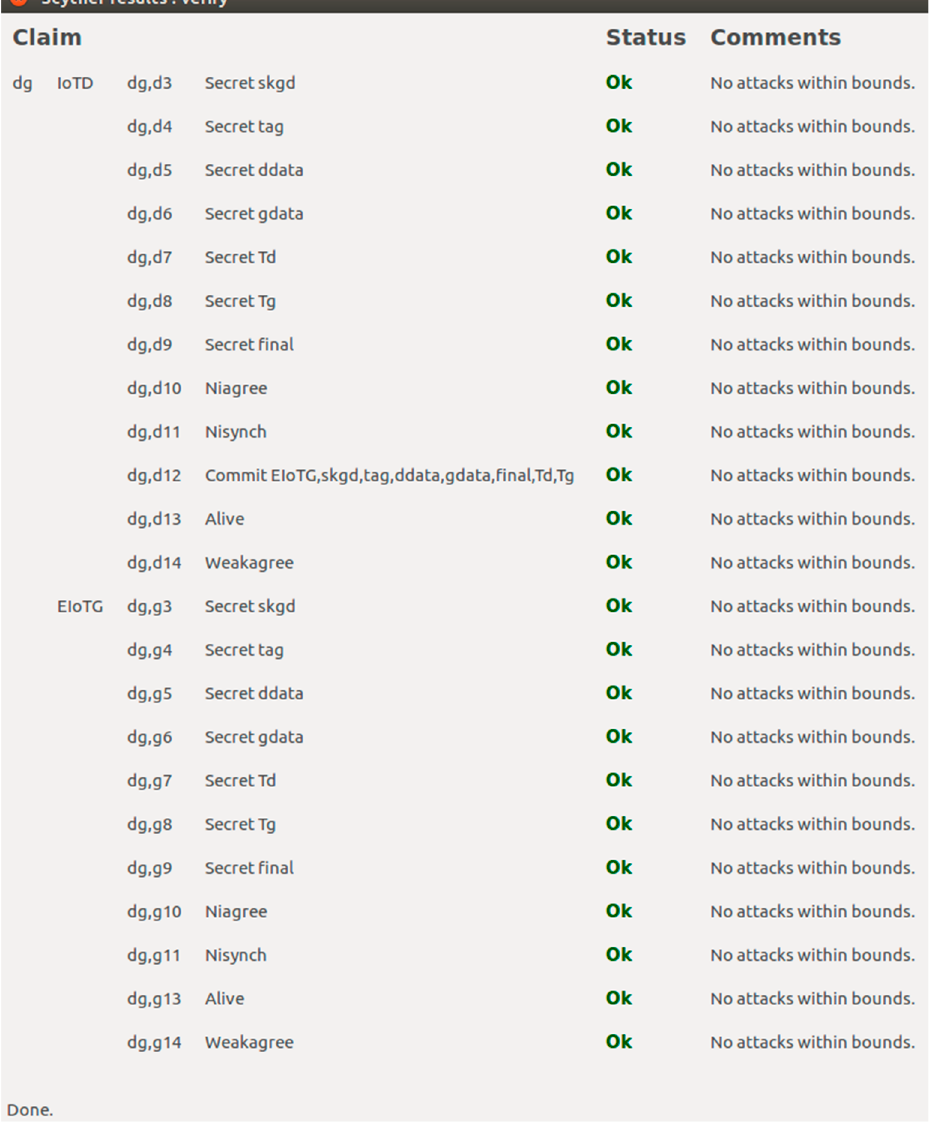
Figure 18. Scyther verification result for secure data transfer between IoTD and EIoTG.